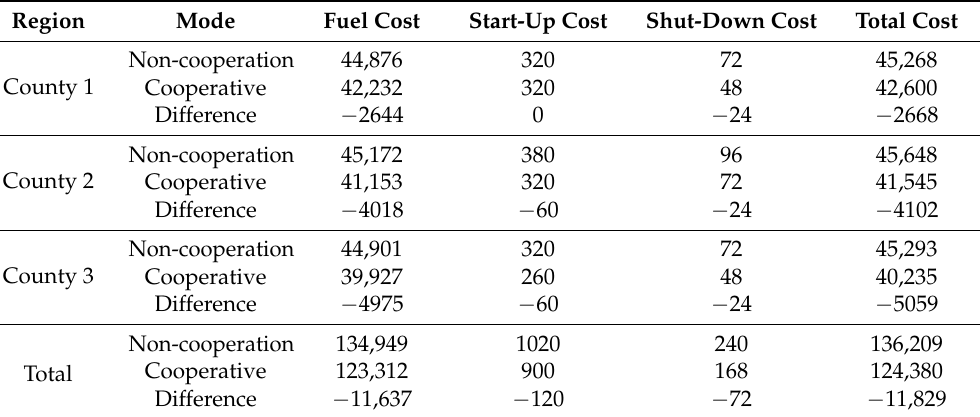
Table 2. Detailed operation costs of thermal